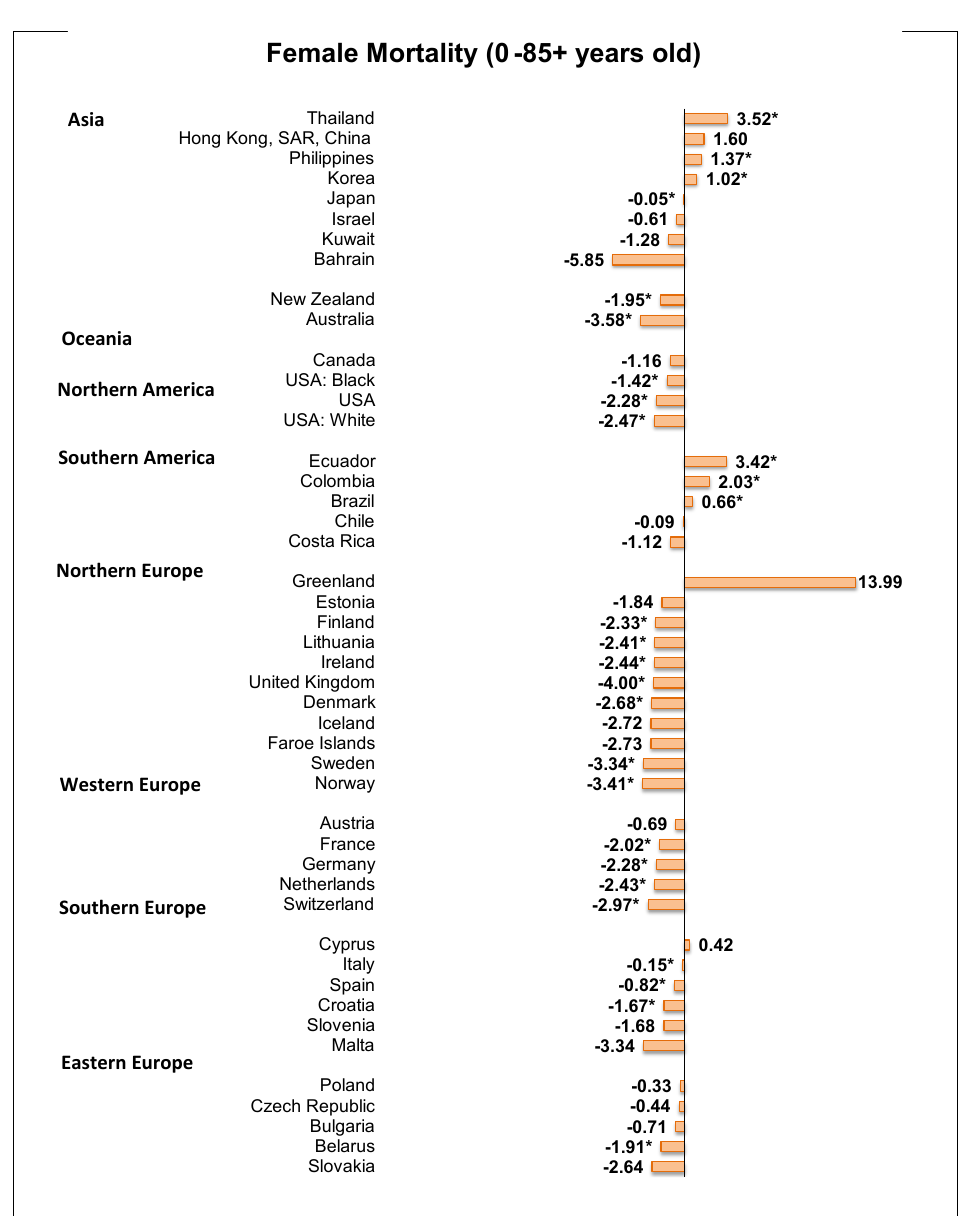
Figure 5. AAPC of mortality of ovarian cancer aged 085+. * Statistically significant.